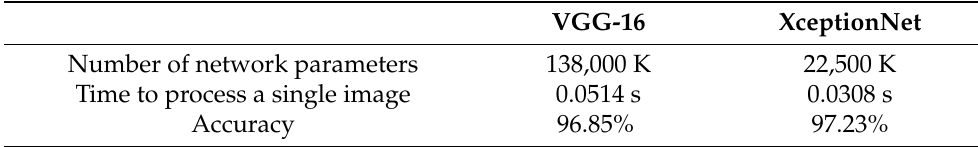
Table 9. Comparison of the accuracy of XceptionNet and VGG-16 on the FaceForensics++ dataset.